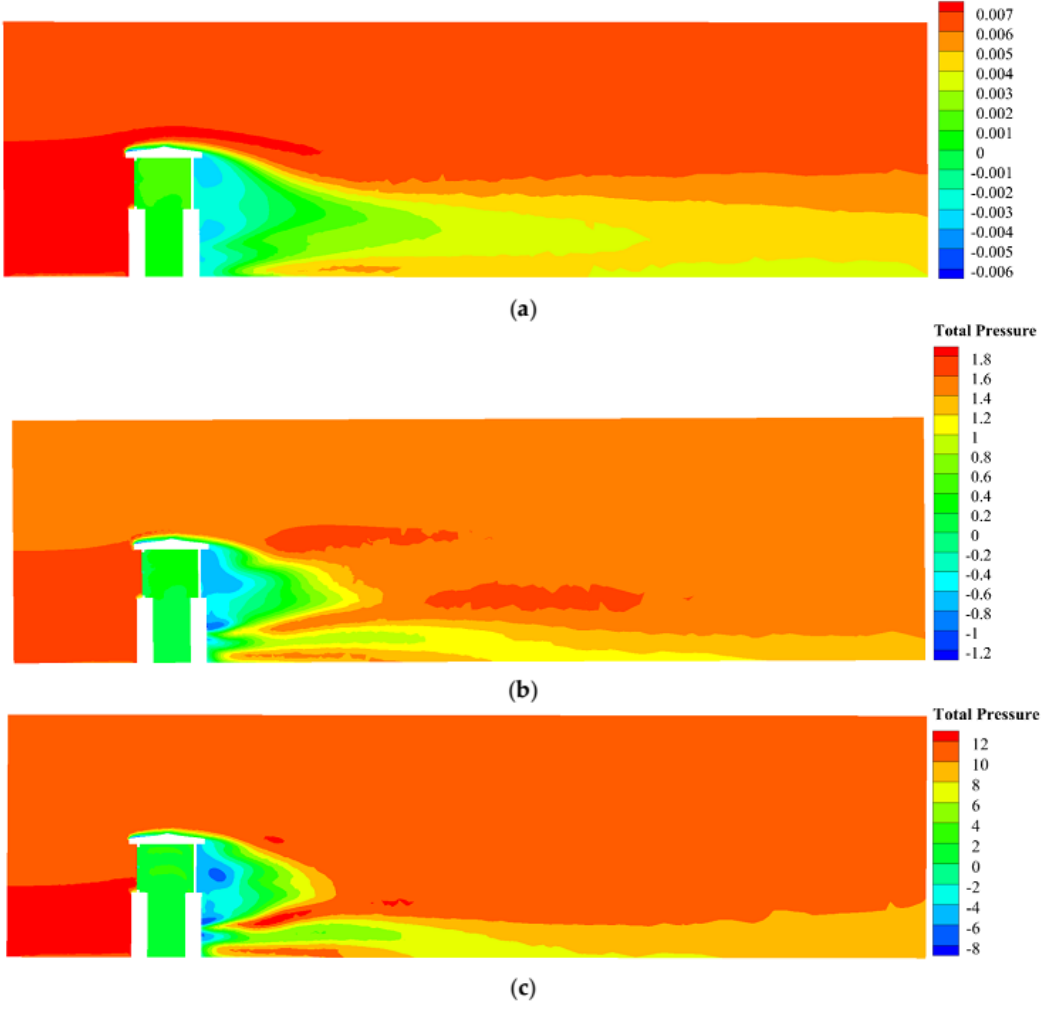
Figure 14. Distribution of total pressure in xz-plane for different inlet wind velocities: ( a ) 0.1 m/s; ( b ) 1.5 m/s; and ( c ) 4 m/s. In this figure, the unit of total pressure is